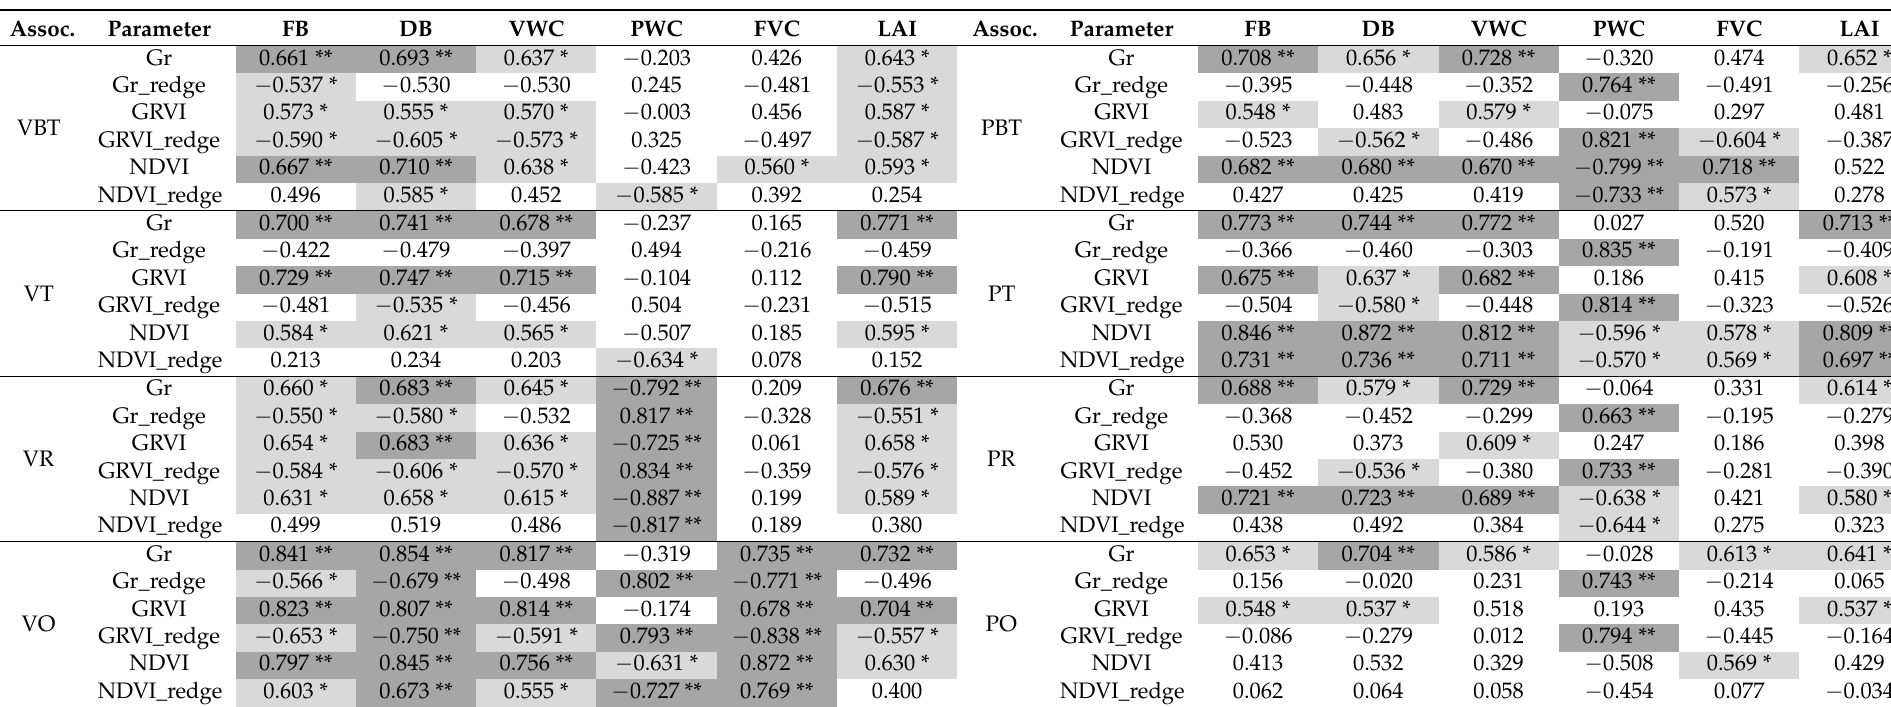
Table A2. Correlations at each association ( n = 14) between field measurements and spectral indices along the whole growing cycle (Pearson Correlation Coefficient).